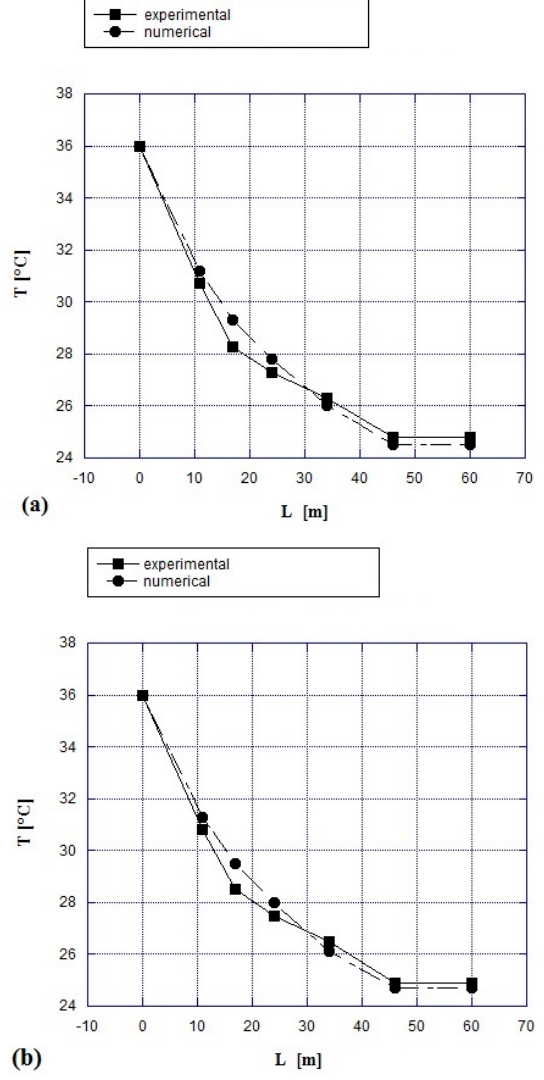
Figure 6. Experimental and numerical results for temperature of the air alongside one pipe of the earth-to-air heat exchanger with the inlet volumetric flow rates of 135 m 3 h − 1 ( a ) and 155 m 3 h − 1 ( b ). Furthermore the EAHX model introduced in this paper was also validated with the experimental results published by Khabbaz et al. [49], related to an Earth-to-Air Heat Exchanger system located in Marrakech (Morocco; Latitude 31°38 ′ 02 ″ N, Longitude − 7°59 ′ 59 ″ E), a location characterized by a hot semi-arid climate.